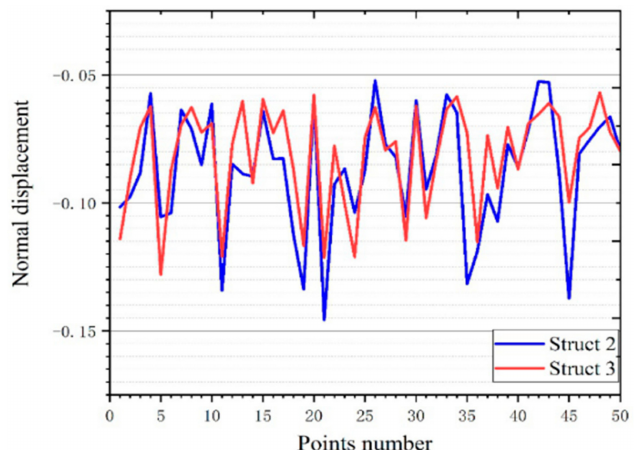
Figure 31. Comparison of the normal displacement of the force point of structure 2 and structure